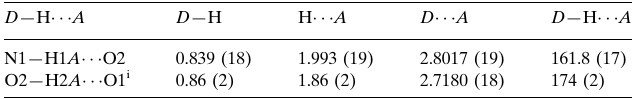
Hydrogen-bond geometry (A˚ , (cid:1)